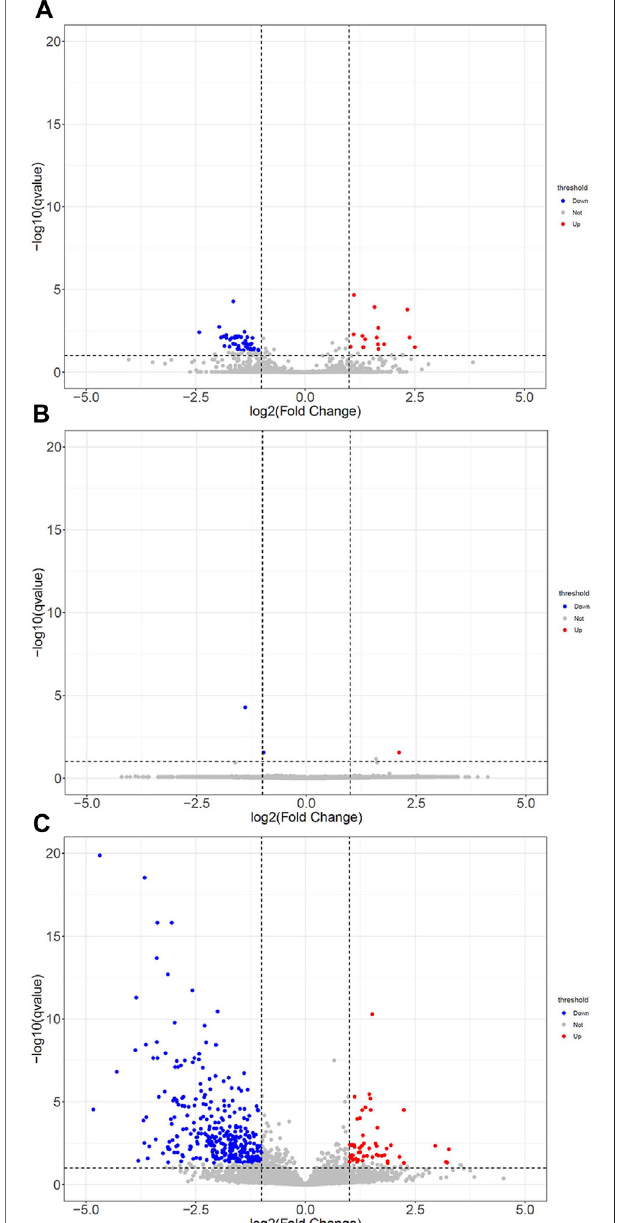
FIGURE 11 | The DEGs with statistical signi fi cance from lung tissues between ARDS mice and ARDS mice were pretreated by different concentrations of NFPX screened using a volcano plot. Red notes indicate upregulated genes, and blue notes indicate downregulated genes. (A) LPSgroupvs.LPS+LNFPXgroup; (B) LPSgroupvs.LPS+MNFPXgroup; (C) LPS group vs. LPS+HNFPX